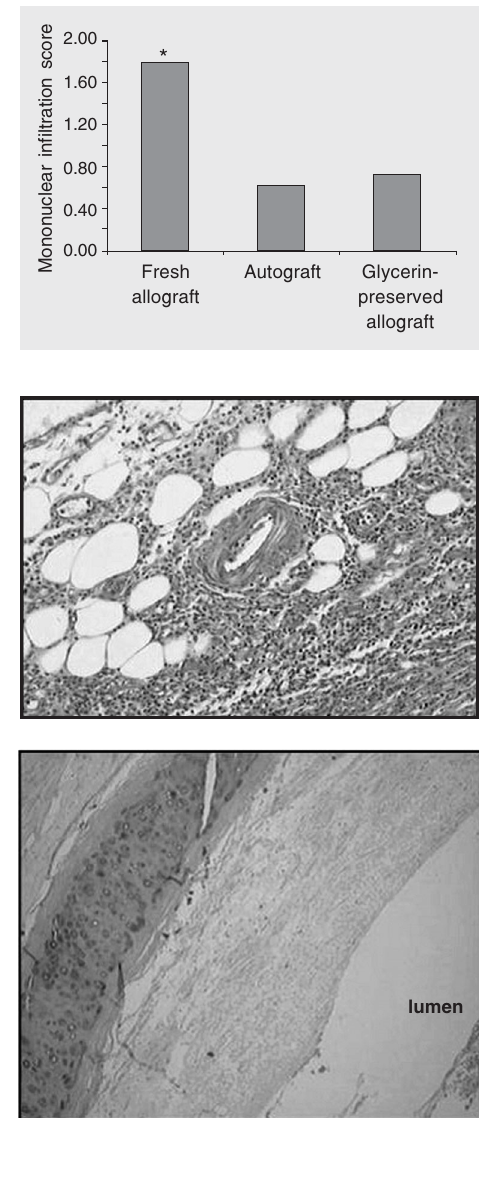
filtration scores for the autograft, glycerin-preserved allograft and fresh allograft groups. *P < 0.05 compared to the autograft and to the glycerin-preserved al- lograft (Dunn test).